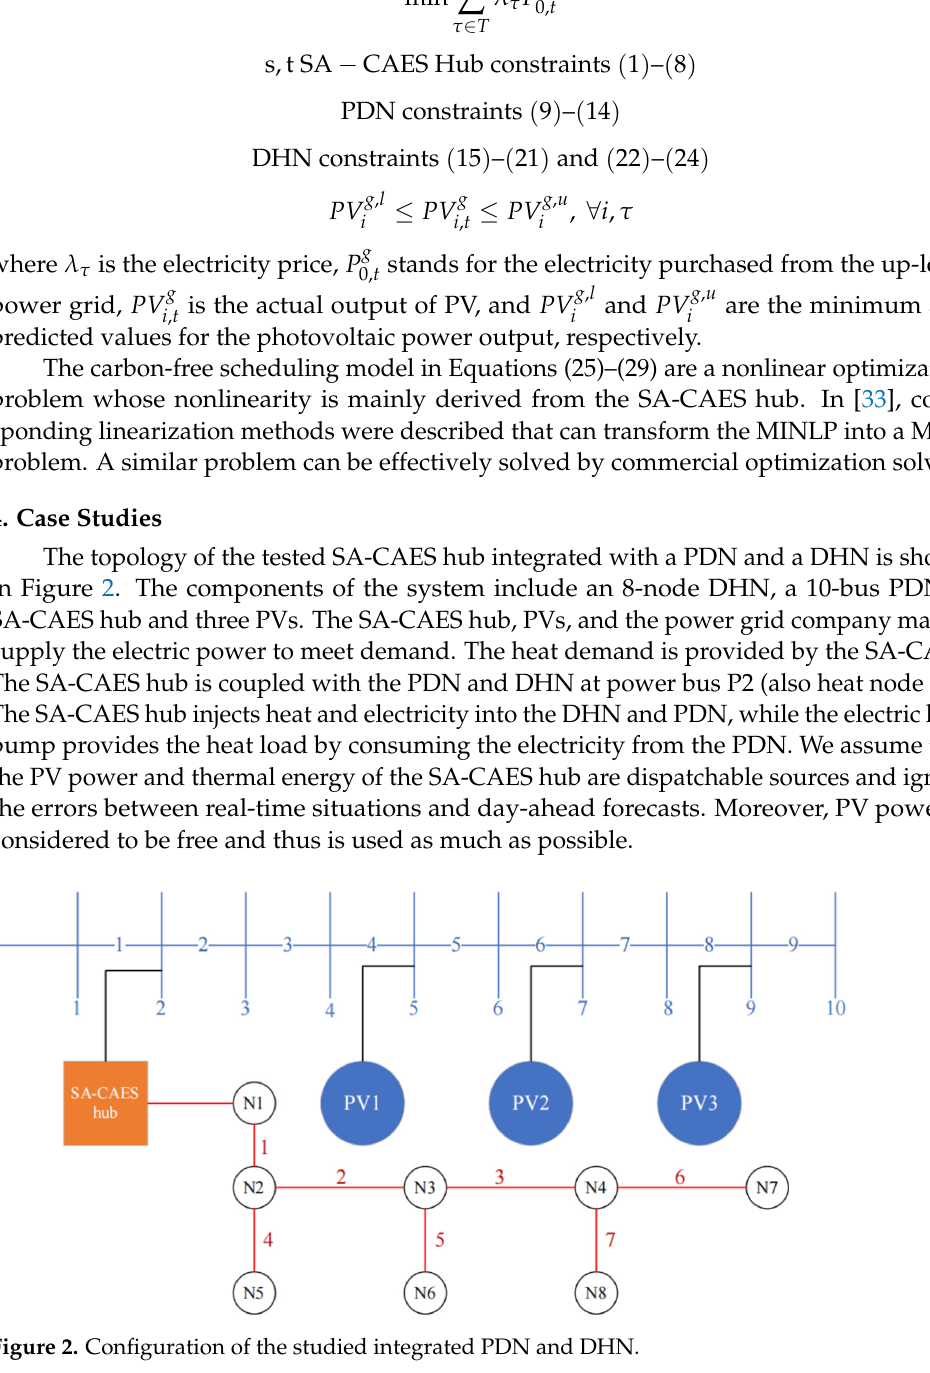
Figure 2. Configuration of the studied integrated PDN and DHN. The price fluctuation of Qinghai Power Company is shown in Figure 3. The data comes from official policy of Qinghai Development and Reform Commission [34]. Figure 4 shows the demand of the heat and power as well as the available solar